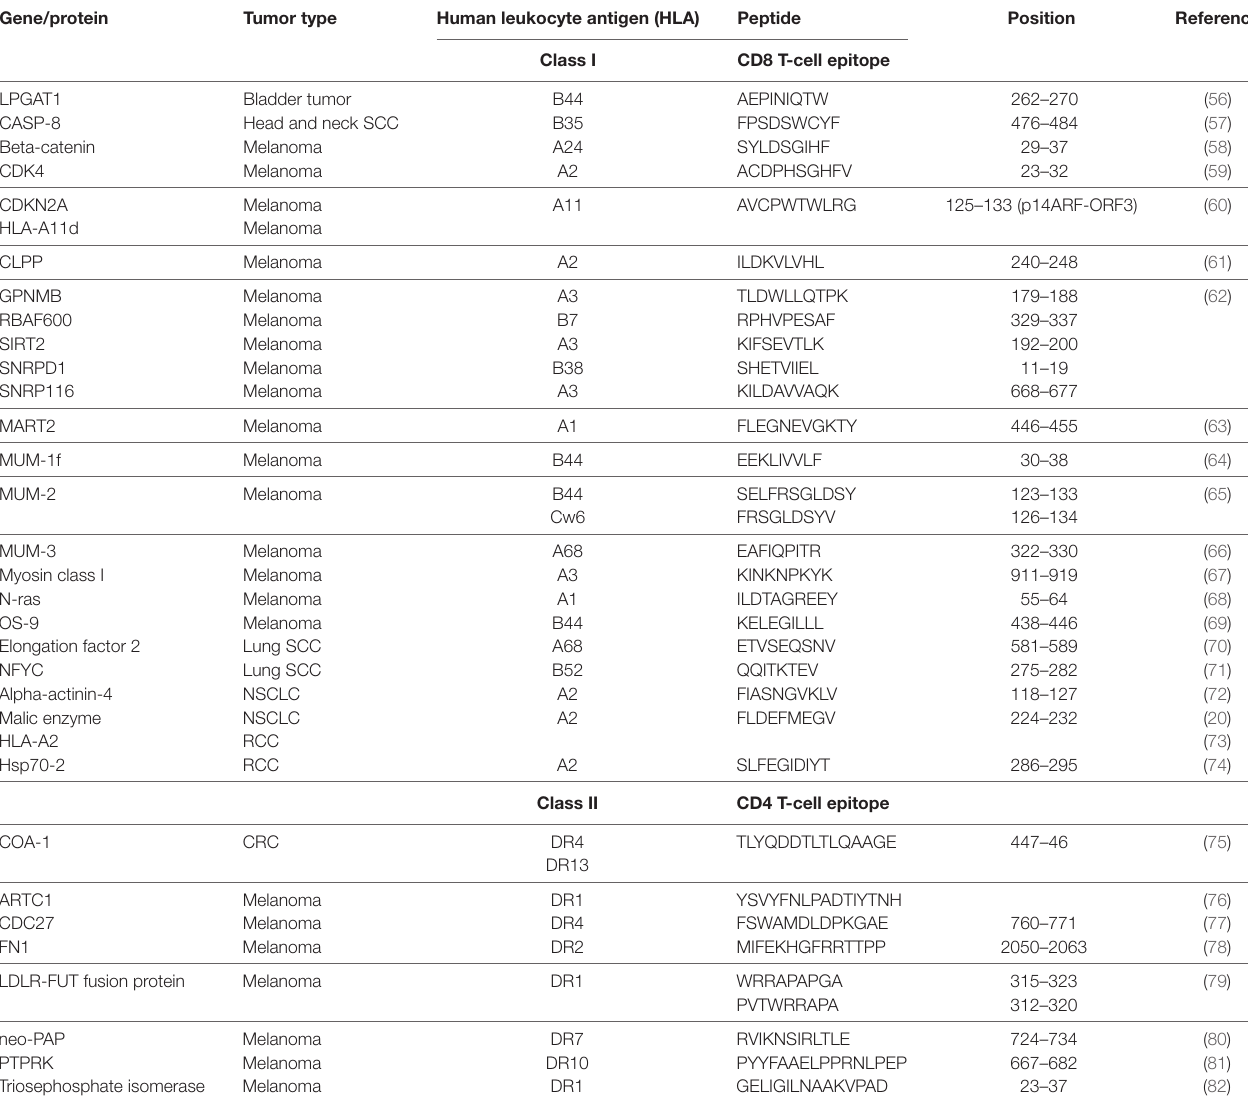
TABLe 2 | Mutant tumor antigens recognized by CD8 or CD4 T cells.